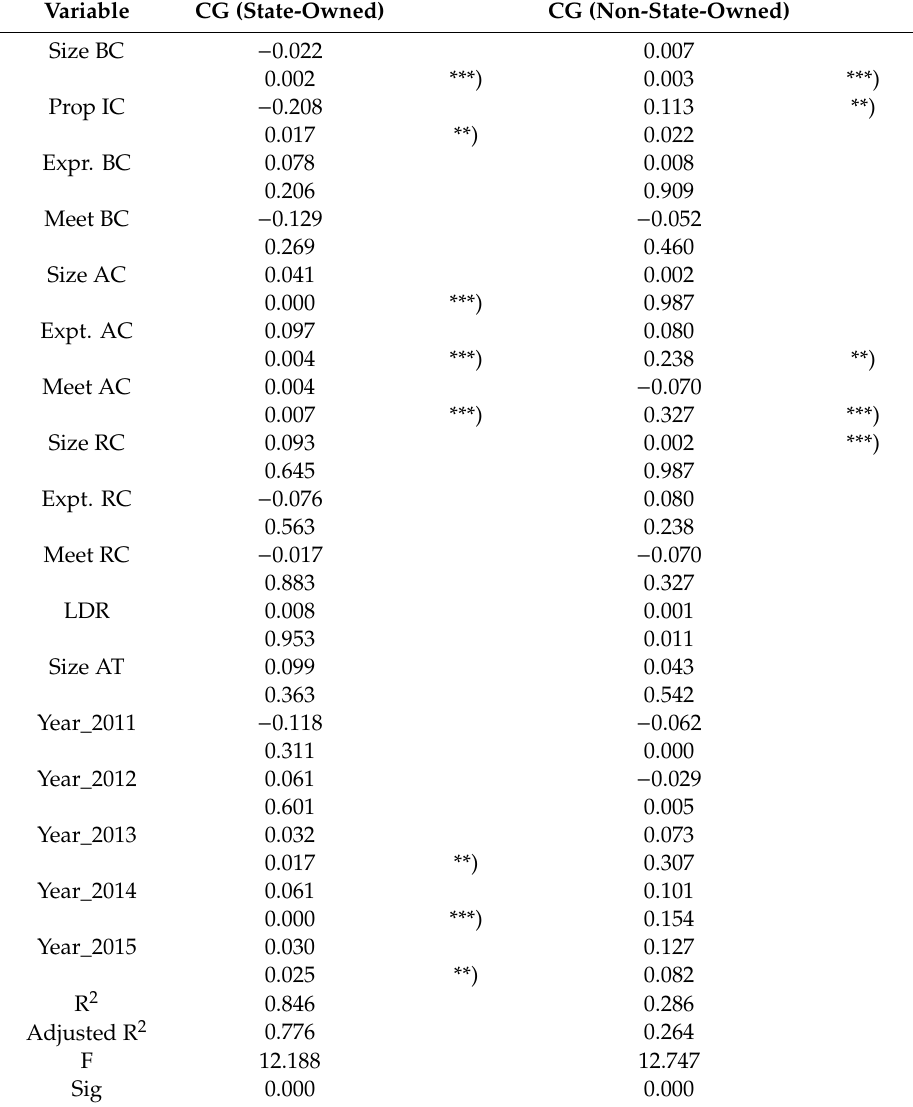
Table 6. Analysis results for state-owned and non-state-owned